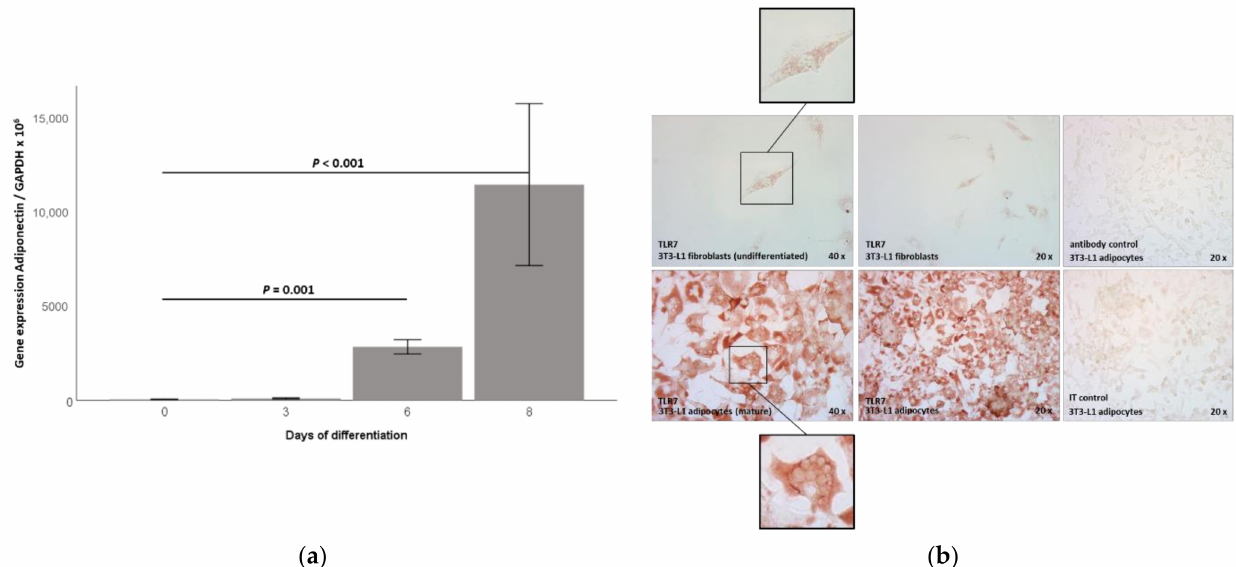
Figure A1. Adiponectin mRNA gene expression is induced during hormonally induced 3T3-L1 adipocyte differentiation, and TLR7 protein is expressed in 3T3-L1 adipocytes. Adiponectin ex- pression was investigated in 3T3-L1 fibroblasts (day 0) and pre-adipocytes (days 3 and 6) during differentiation into mature adipocytes (day 8). ( a ) Adiponectin mRNA levels (analyzed by RT-PCR) exhibited an strong and significant increase, indicating successful adipocytic differentiation ( n = 11 each); ( b ) Immunocytochemistry demonstrated a strong induction of TLR7 protein during adipocyte differentiation, which appeared to be predominantly in the cytoplasm of adipocytes (representative sections are shown, inserts show higher magnification of individual